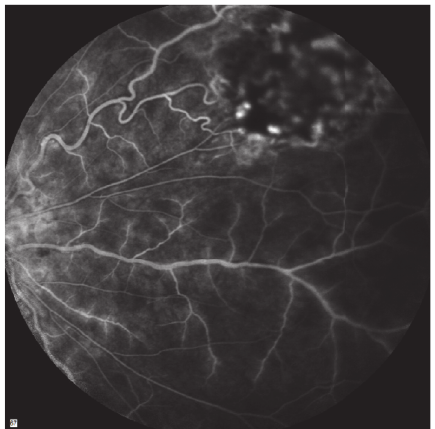
Figure 2: FFA of the right eye revealing retinal vasculitis and astrocytoma.